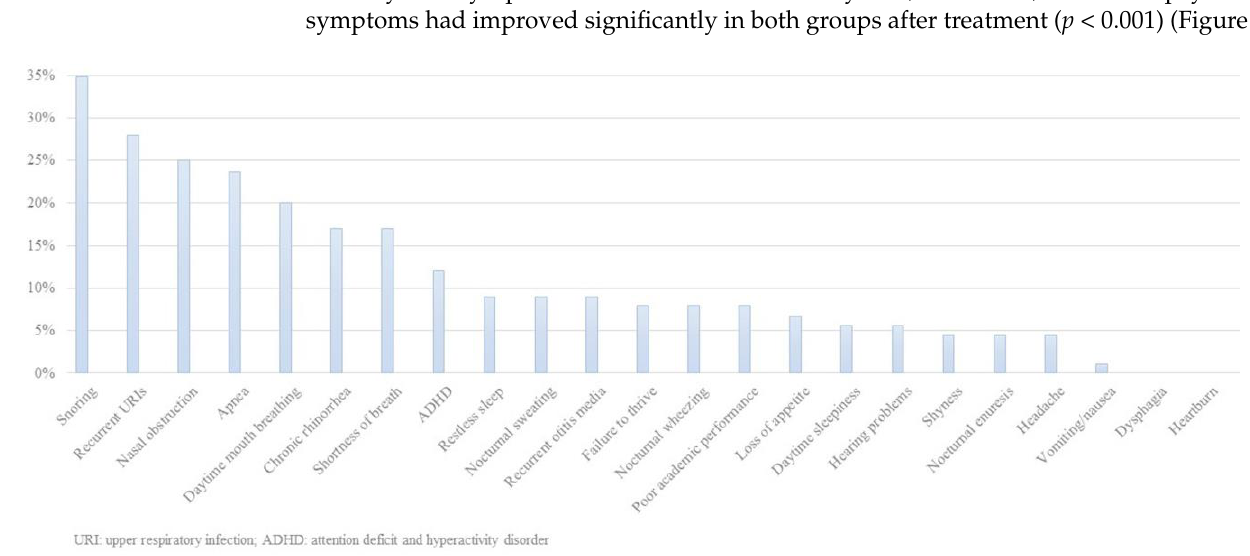
Figure 3. Post-treatment clinical manifestations of apnea–hypopnea syndrome during sleep.